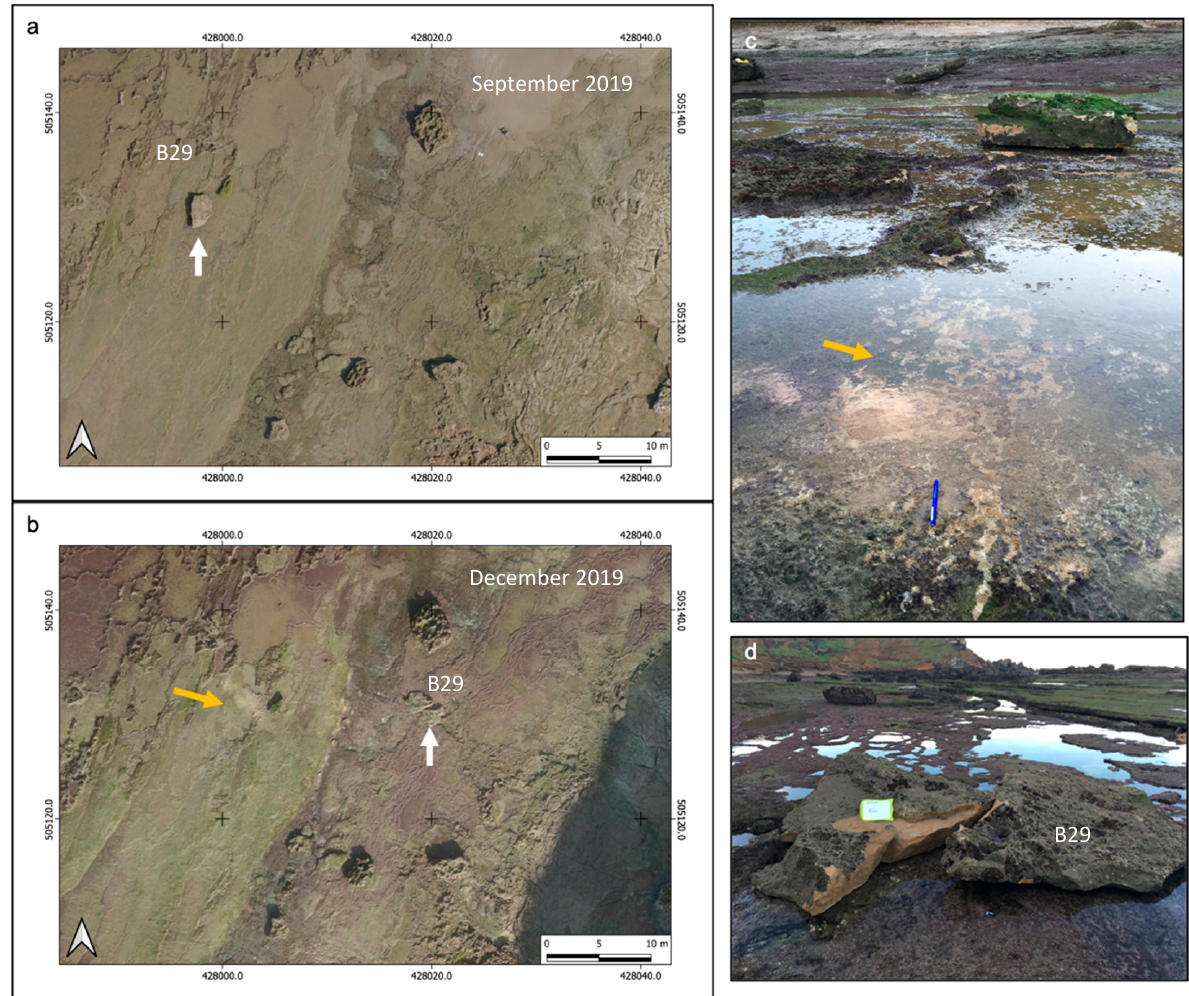
Figure 11. ( a ) Initial position and ( b ) displacement of boulder B29 (white arrows); the orange arrows ( b , c ) show the initial position and trace of the B29 pedestal; bleu pen in ( c ) for scale ( d ) Post-storm position of B29.